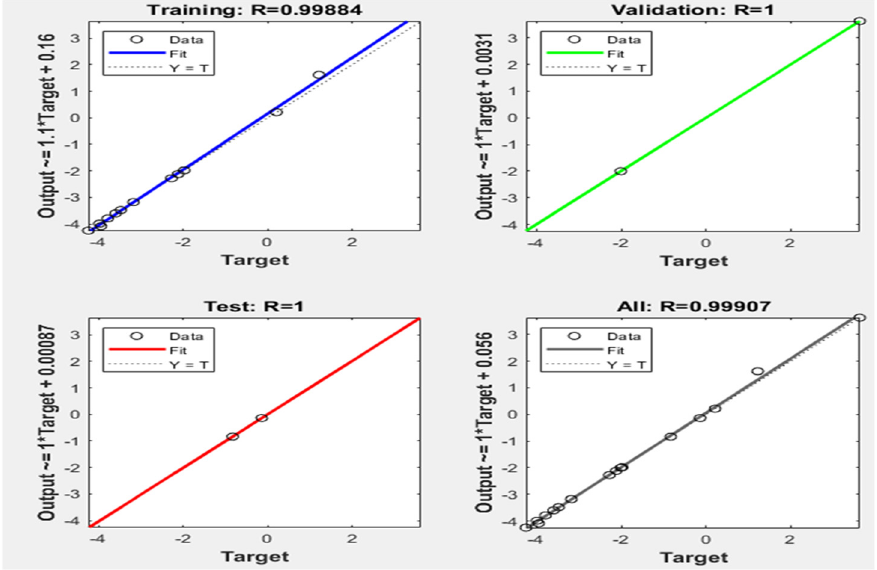
Figure 14. Regression analysis of the THD. Table 6. Comparison of S/N ratio between Taguchi and